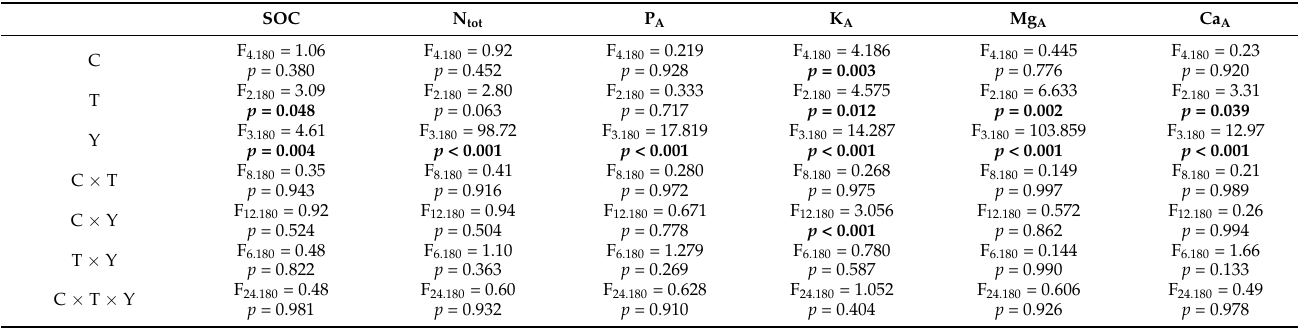
Table 6. Results of the full-factorial analysis of variance between the crops, winter cover crop management systems, yearly differences and their combined interactions of which effects were tested on different soil chemical properties.